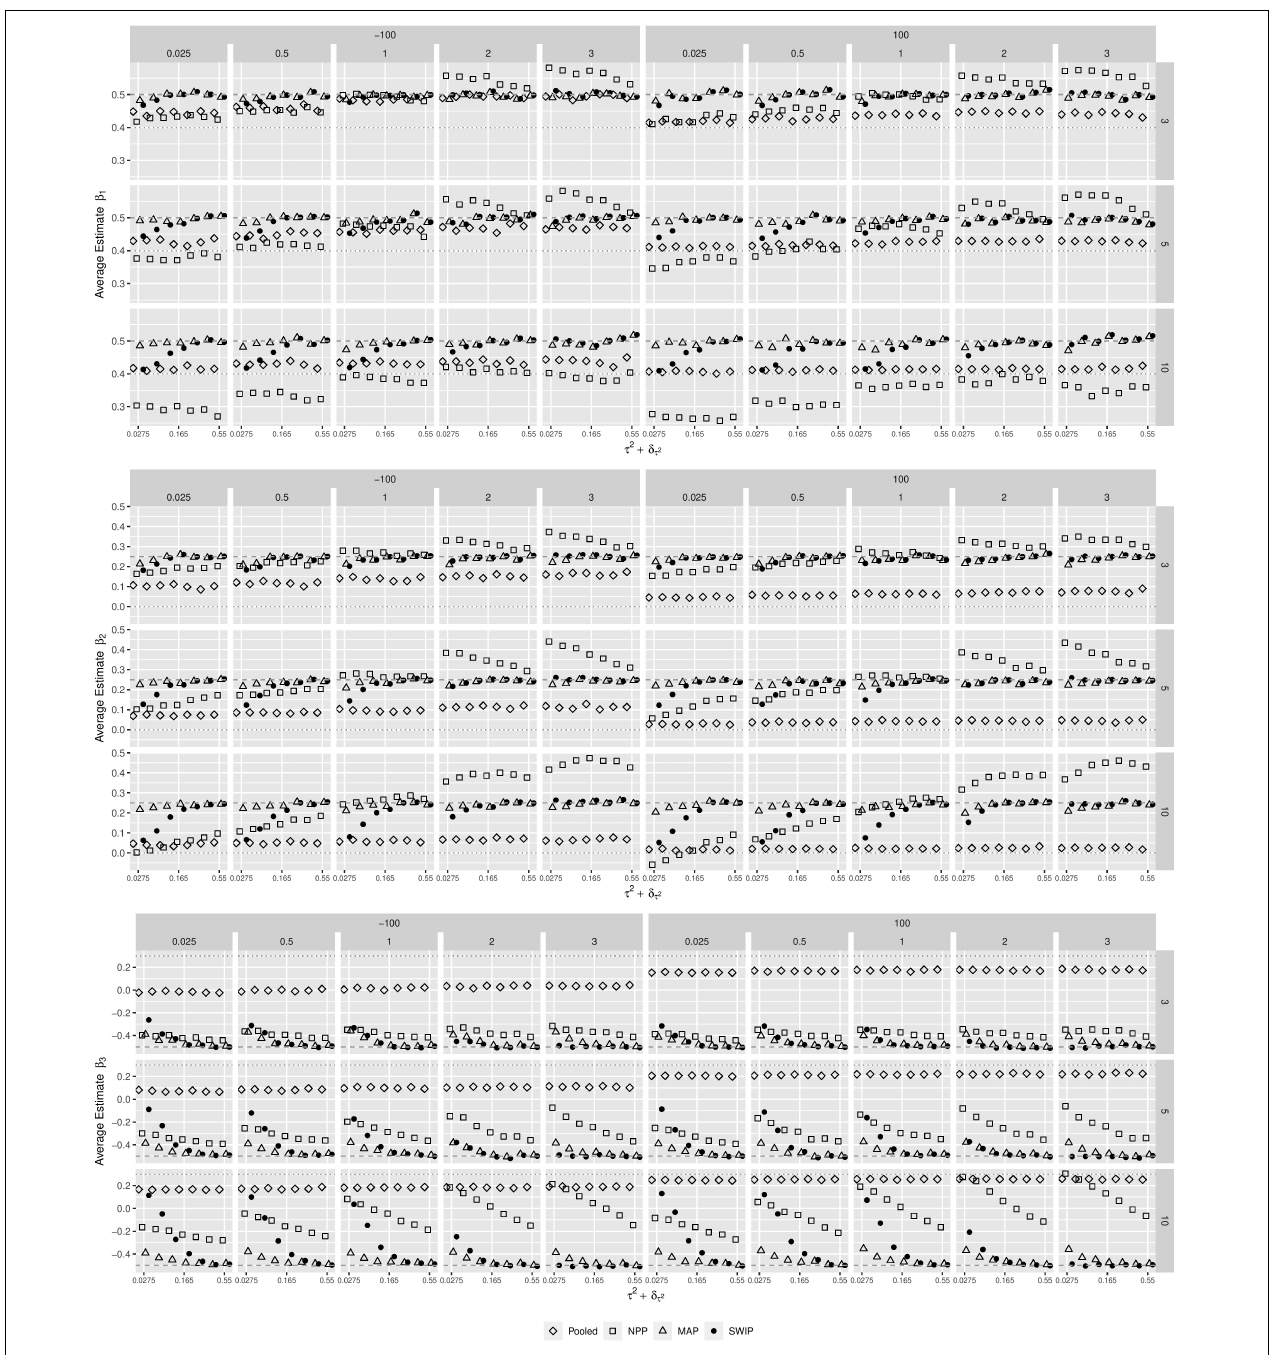
FIGURE 2 | The behavior of the parameter estimates across simulation conditions. The similarity of the focal and the previously conducted studies decreases from left to right . Pooled = pooled Bayesian analysis; NPP = normalized power prior; MAP = meta-analytic predictive prior; SWIP = similarity-weighted informative prior distribution. The dashed horizontal line represents the true value of the respective regression coefficient of the focal study. The dotted horizontal line represents the true (generating) meta-analytic mean of the respective regression coefficient.